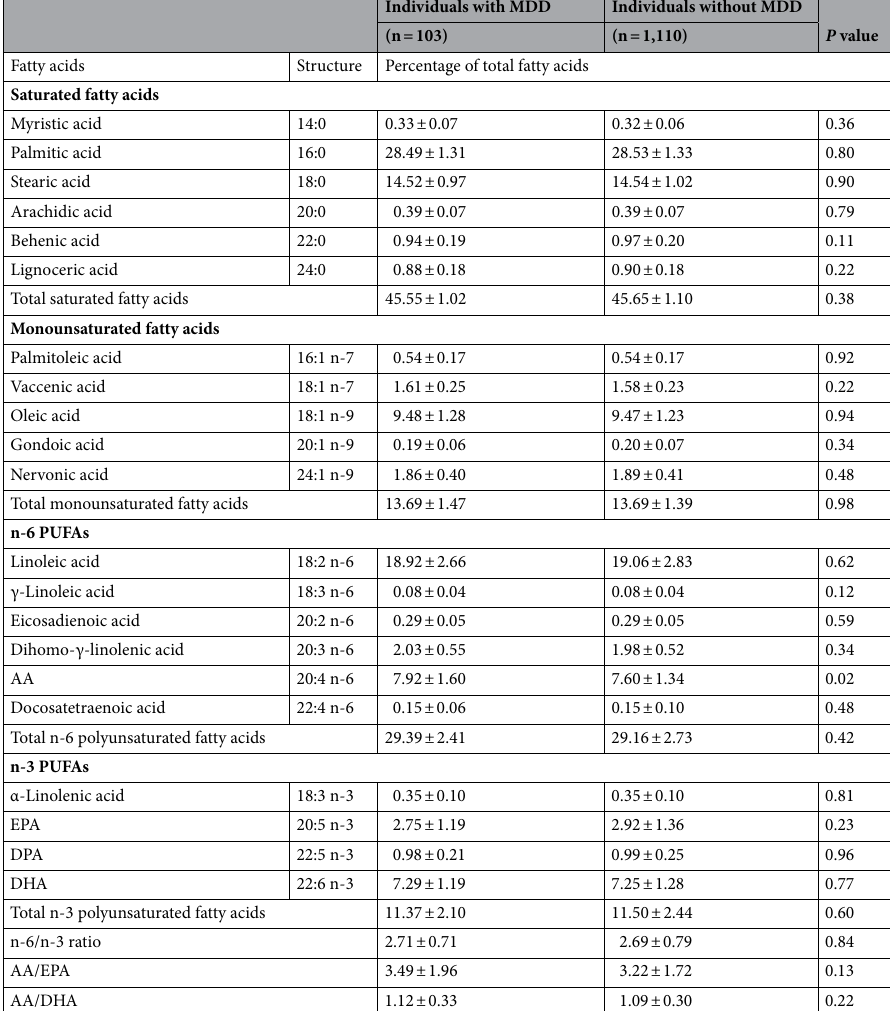
Table 2. Plasma fatty acid compositions of individuals with and without MDD. Values are means ± SD. Abbreviations: AA, arachidonic acid; DHA, docosahexaenoic acid; DPA, docosapentaenoic acid;